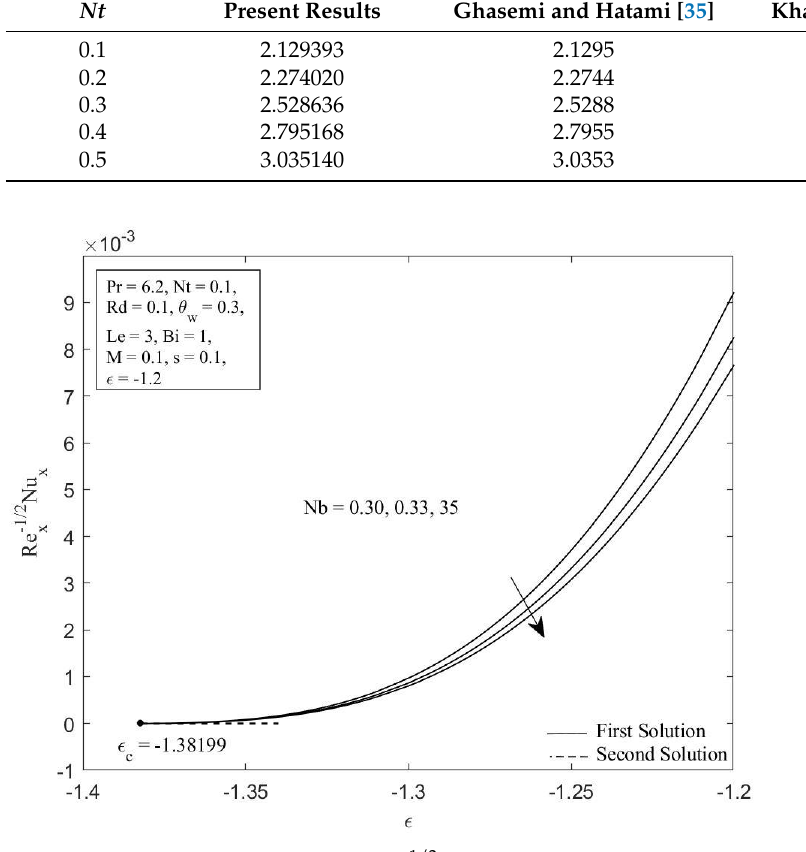
Figure 2. Local Nusselt number Nu x Re − 1/2 x against ε for diverse values of Nb .